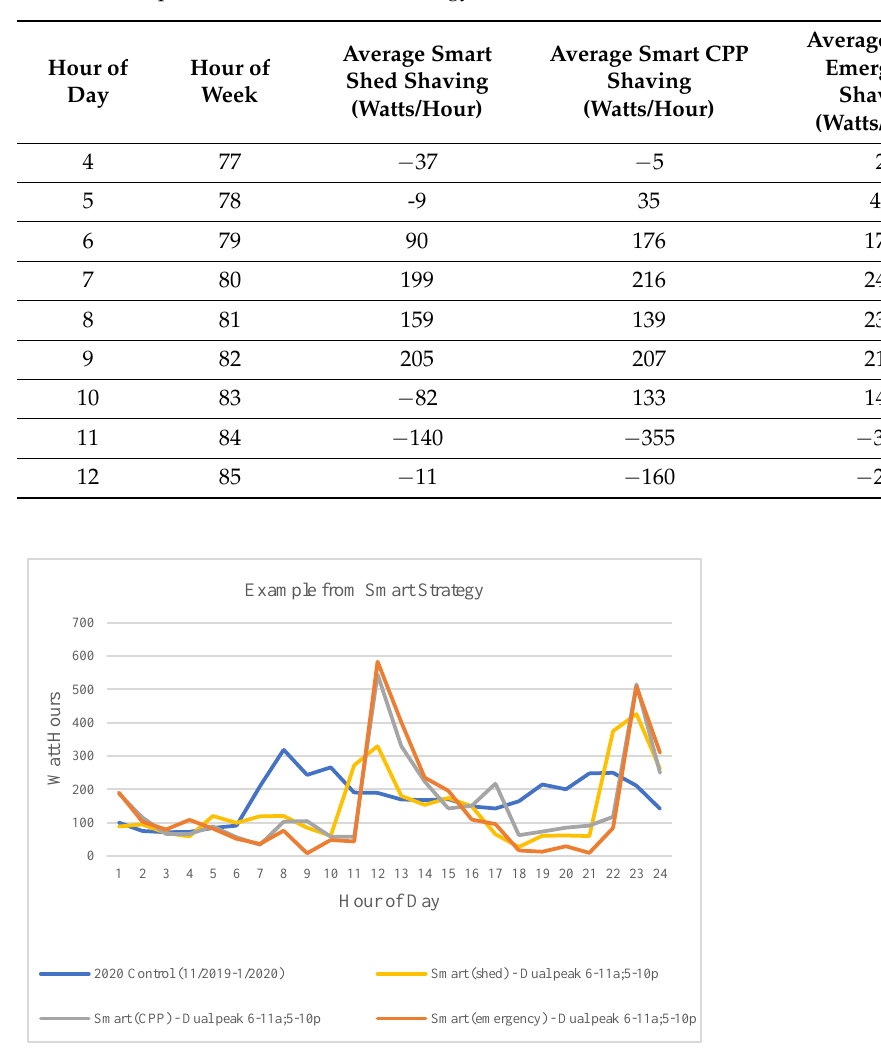
Table 7. Example Results from Smart Strategy.